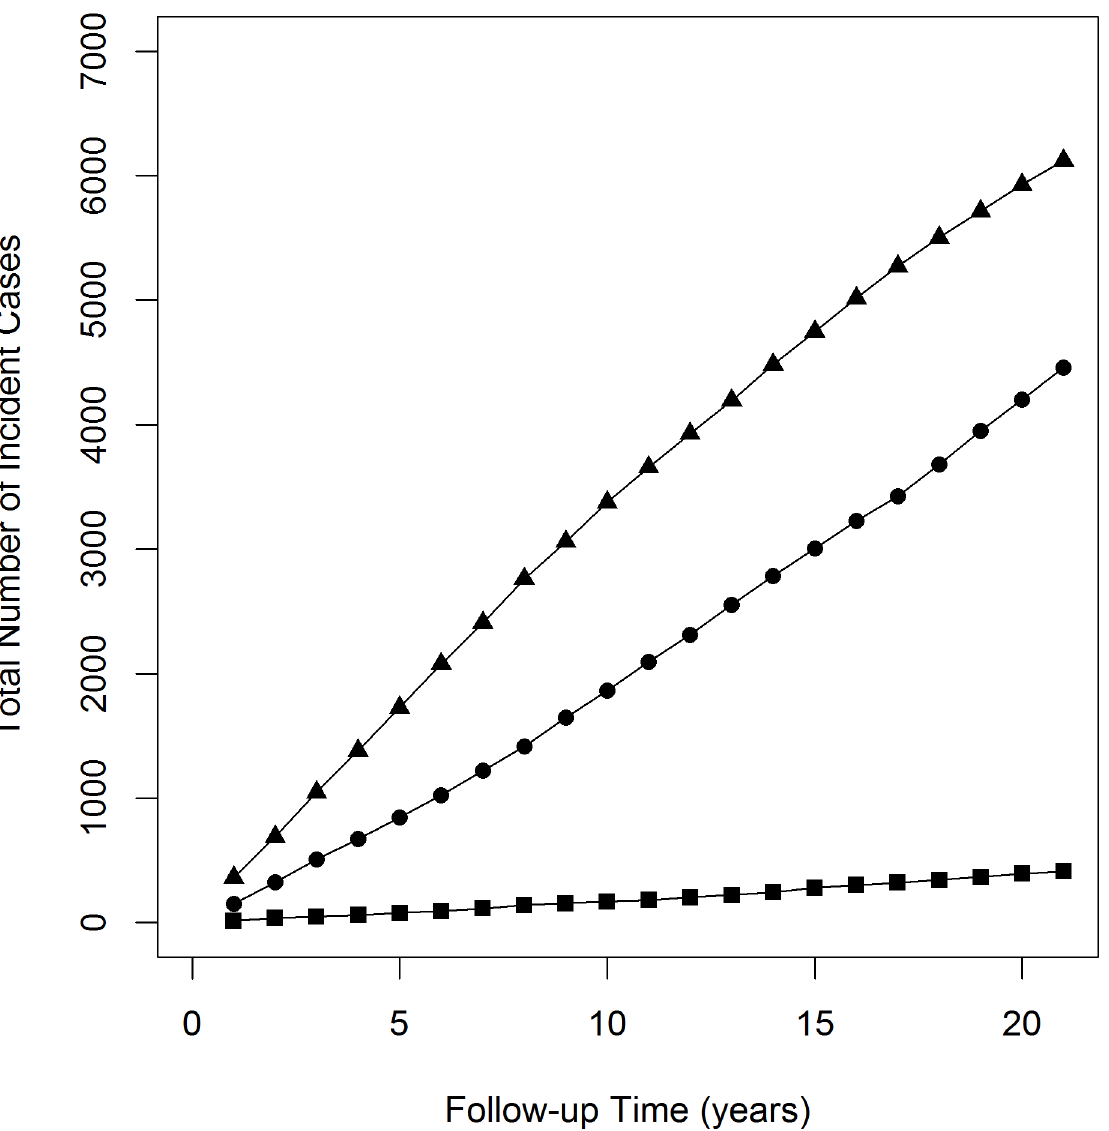
Fig 1. Total Number of Incident Cases in the Follow-up Period. Square, circle and triangle represent the total number of incident cases for Parkinson disease, dementia, and diabetes